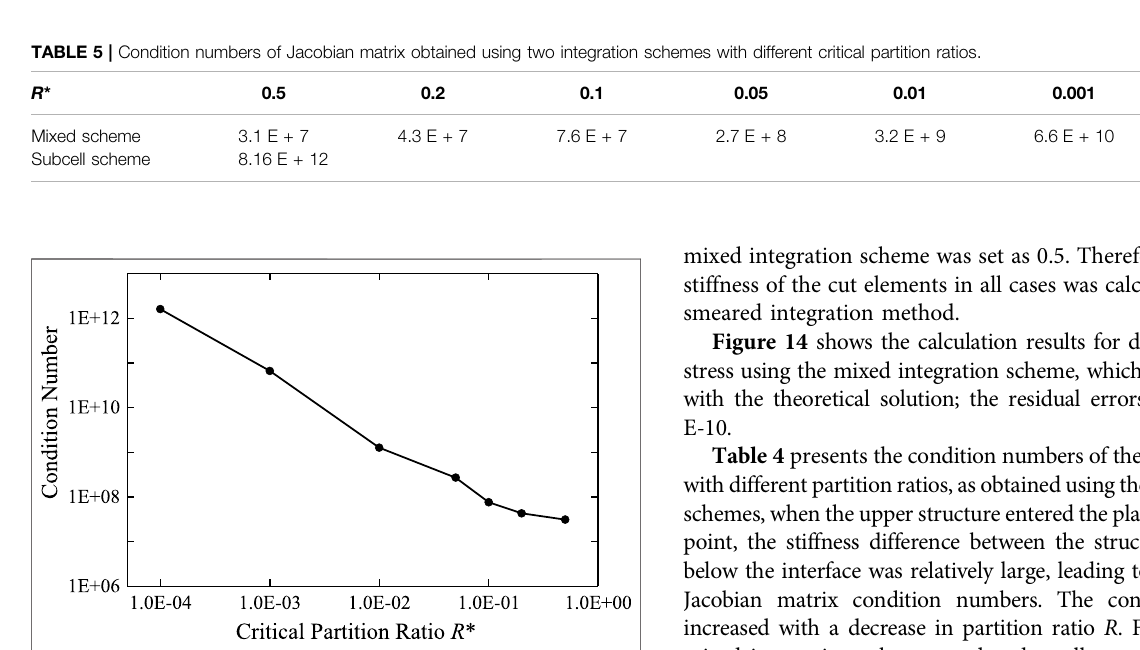
Frontiers in Earth Science |